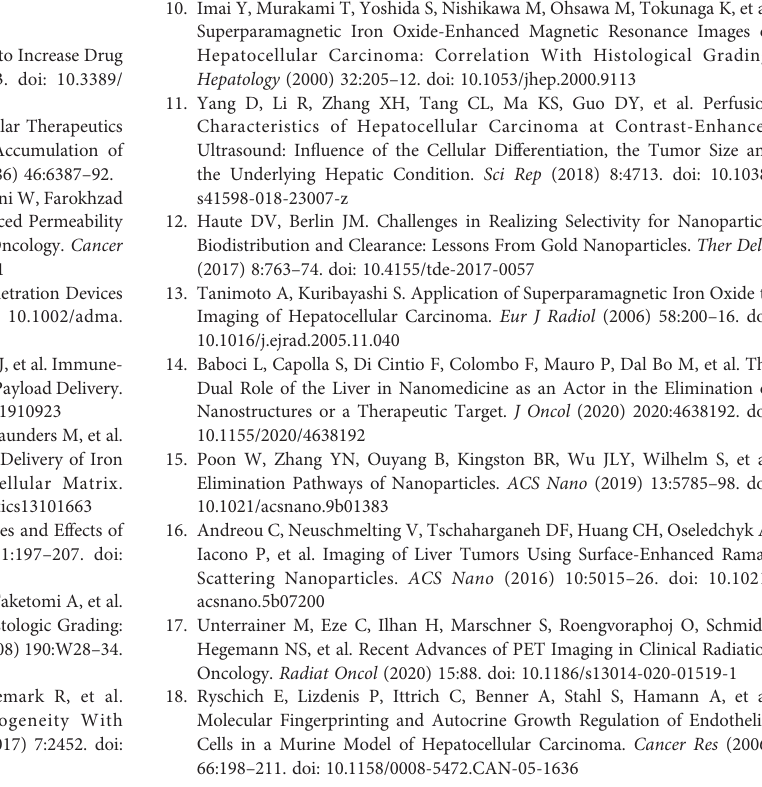
Supplementary Figure 1 | Gating strategies and fl ow cytometry plots of quanti fi cation of CD11b + /CD68 + , CD8 + /CD45 + and CD4 + /CD45 + in normal liver (from C3H mice)and ALB-TagHCC tumors followingi.v.injections ofPBSorTNF a - CSG (5 m g dose/day) for 5 consecutive